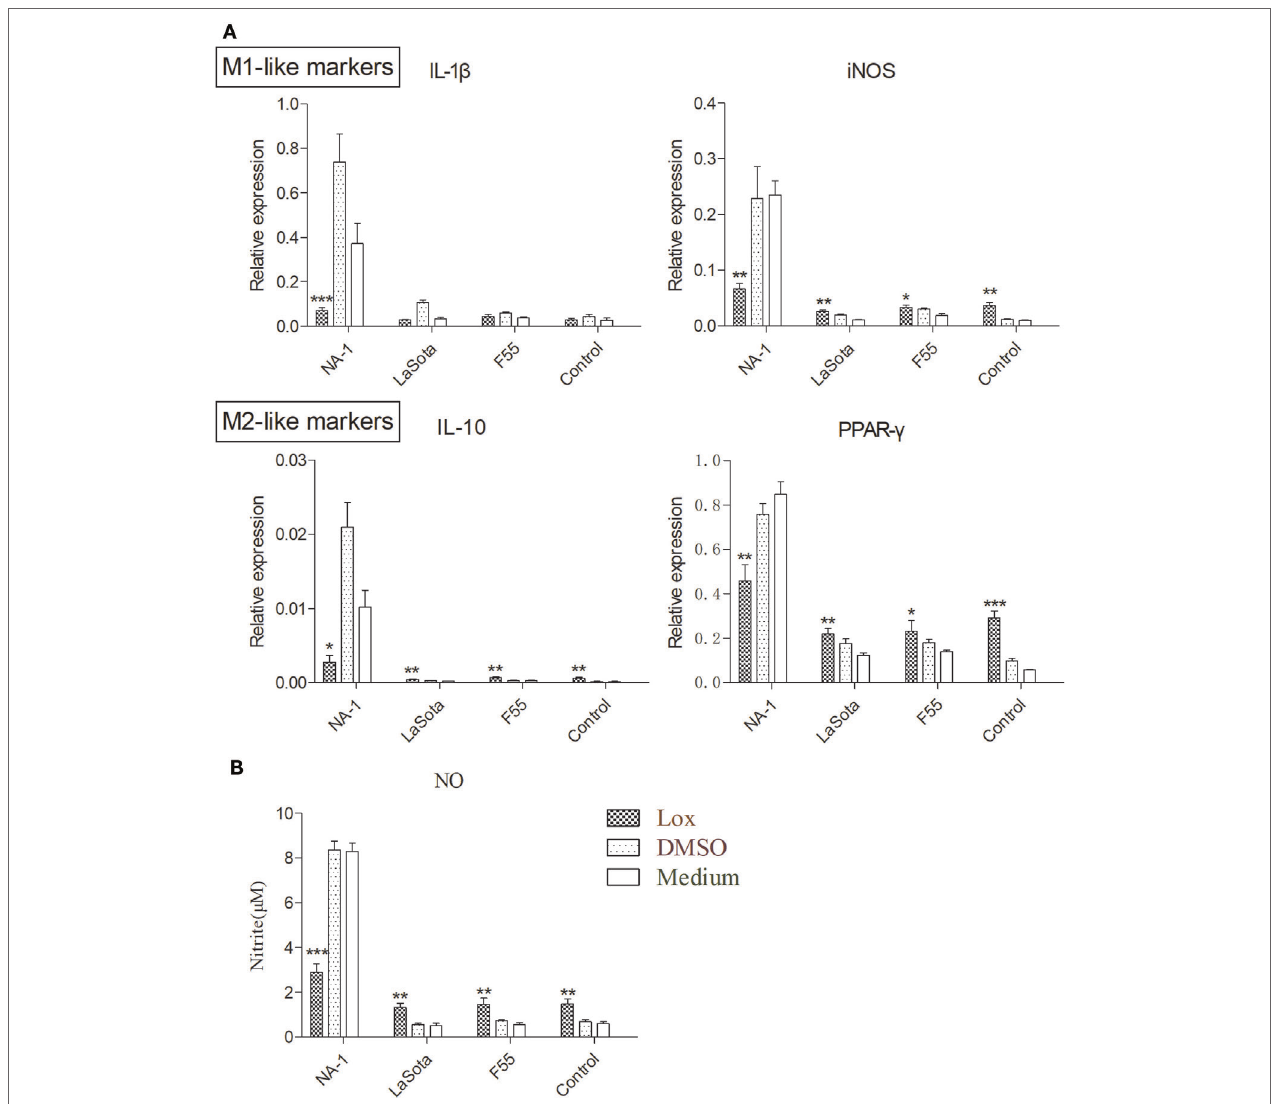
FigUre 6 | TLR7 agonist decreases macrophage polarized activation markers in cells infected virulent virus rather than lentogenic virus. HD11 cells were pretreated with 1 mM loxoribine for 6 h and subsequently infected with three different virulence and genotypes Newcastle disease virus (NDV) strains at 2 multiplicity of infection for 48 h; thereafter, expression levels of M1-like (IL-1 β and iNOS) and M2 (IL-10 and PPAR- γ ) genes in HD cells (a) and M1-like protein nitrite concentration in the supernatants (b) were measured by qPCR and Griess assay, respectively. All qPCR data were normalized to the geometric mean of cellular endogenous genes β -actin and hydroxymethylbilane synthase and calculated using the 2 −Δ Ct method. All values are shown as mean ± SEM ( n = 4–6) and differences were considered significant if * P < 0.05, ** P < 0.01, and *** P < 0.001 as compared to the respective control (untreated) cells. All data are representative of at least three independent